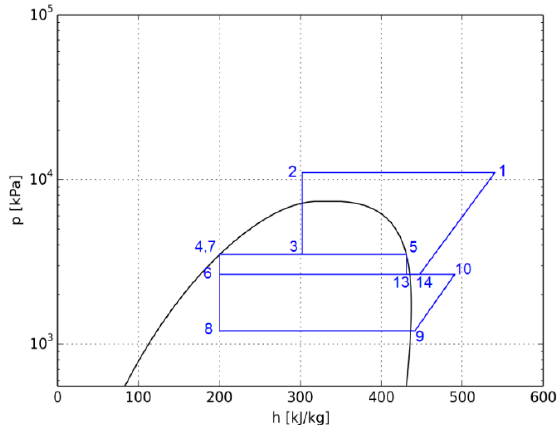
Figure 2. p–h diagram of a conventional transcritical R744 booster supermarket refrigeration system (CB).